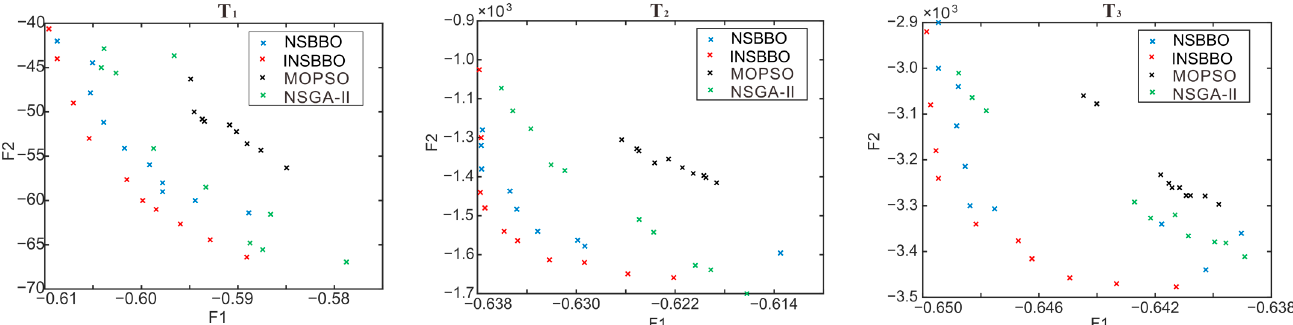
Figure 15. Comparison charts of INSBBO and NSBBO solving the upper objective function Pareto front solution in different time domains.